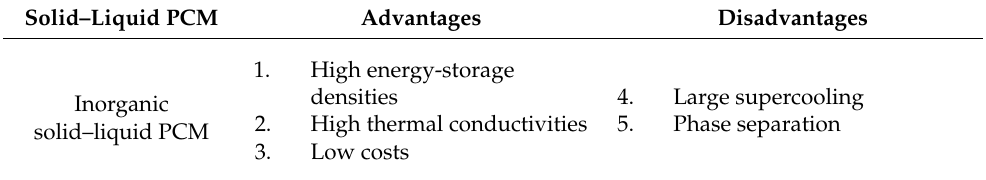
Inorganic solid–liquid PCM